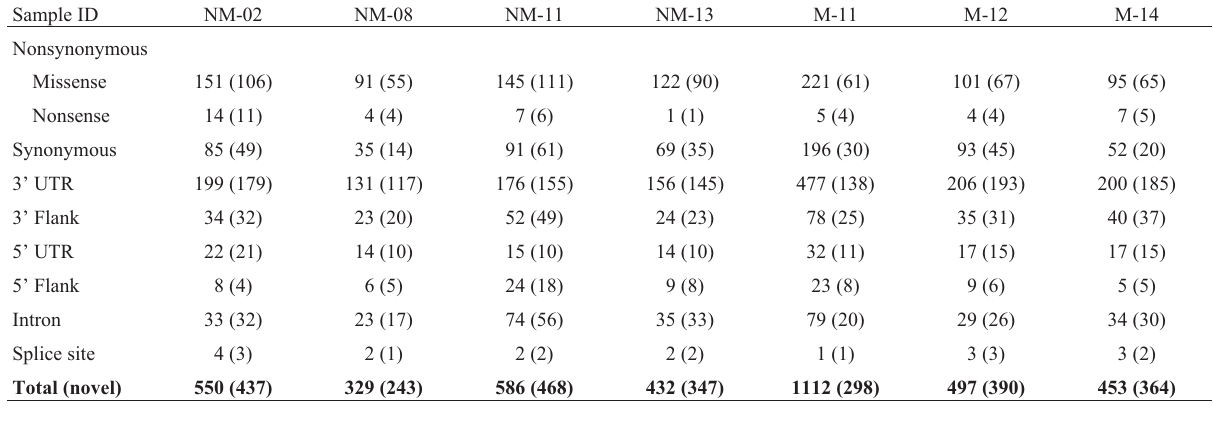
Table 2 - Number of somatic single nucleotide variants (SNVs) in HNSCC patients; total and (novel).